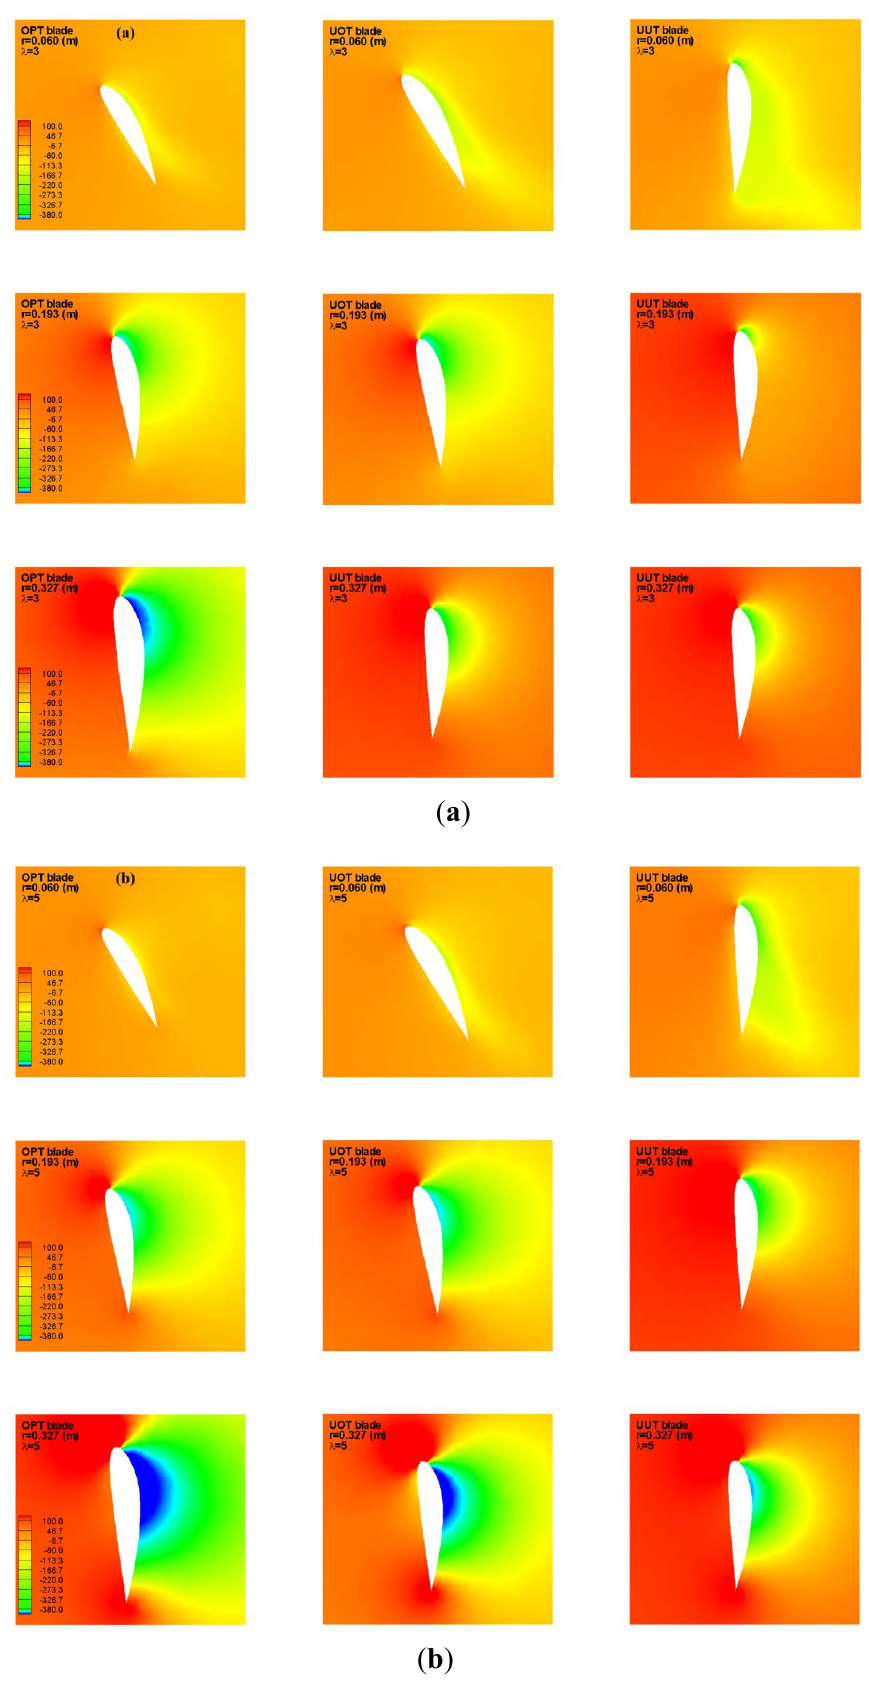
Figure 12. ( a ) The distributions of the pressure field for OPT, UOT and UUT blades in r = 0.060 (m), r = 0.193 (m) and r = 0.327 (m) at V = 10 (m/s) and λ = 3; ( b ) λ = 5; ( c ) and λ =